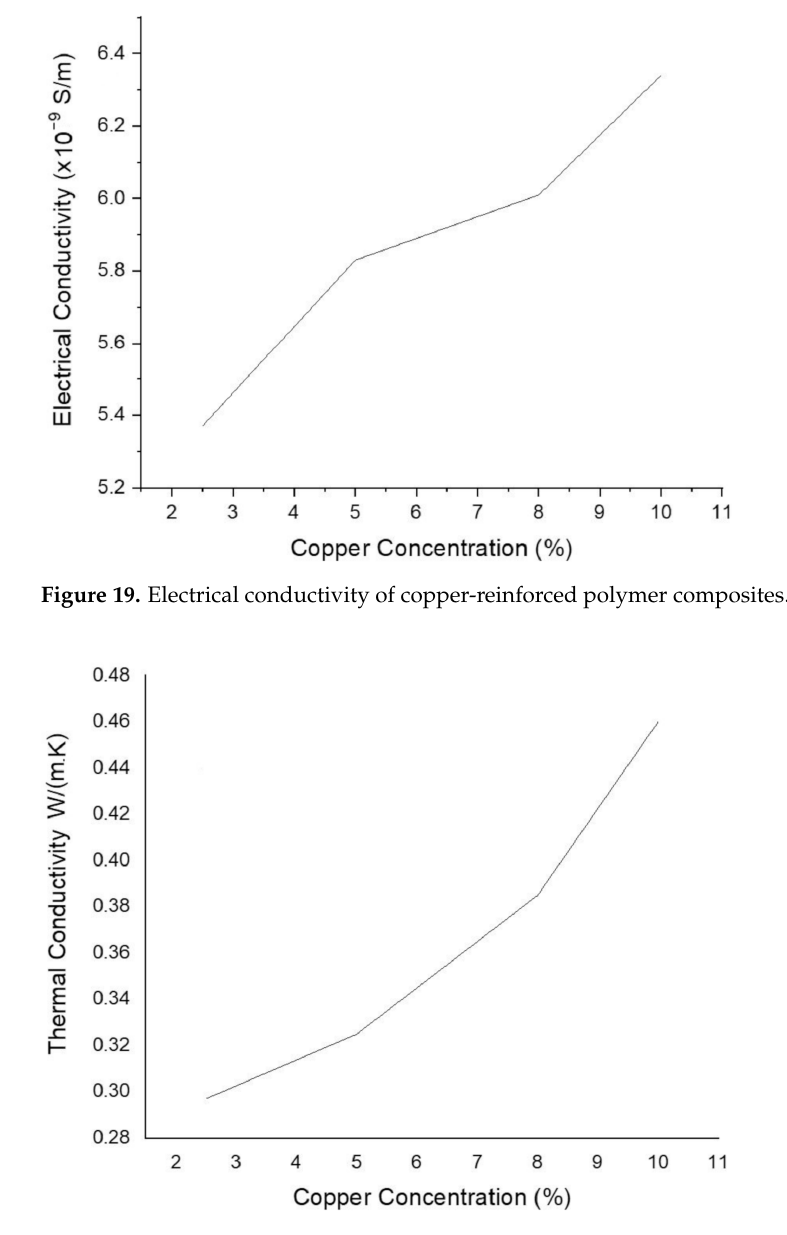
Figure 20. Thermal conductivity of copper-reinforced polymer